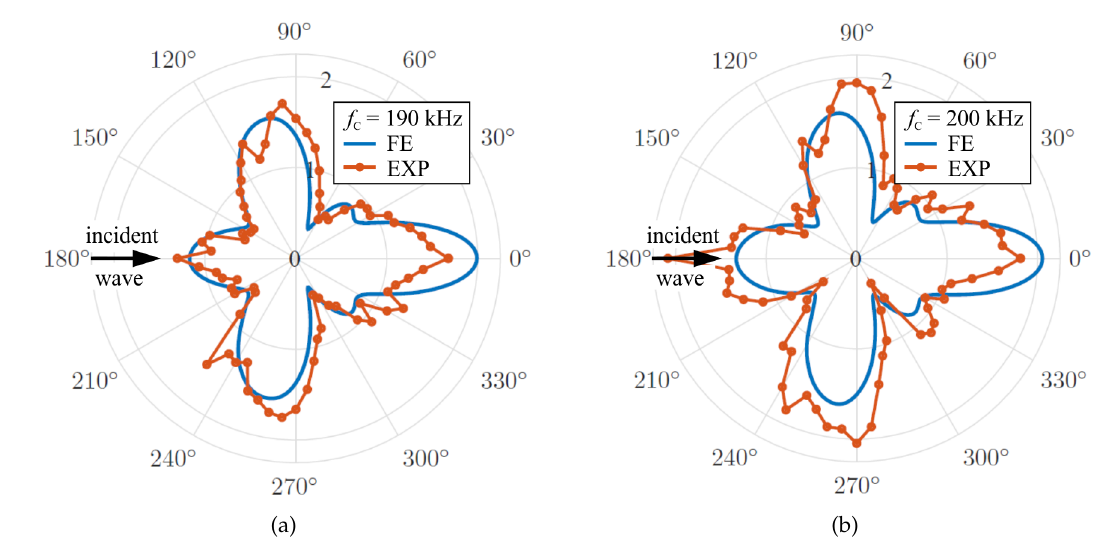
Figure 10. Comparison of numerically calculated (FE) and with laser scanning vibrometry measured (EXP) damage interaction coefficients C AA for burst center frequency: ( a ) f c = 190kHz; and ( b ) f c = 200kHz